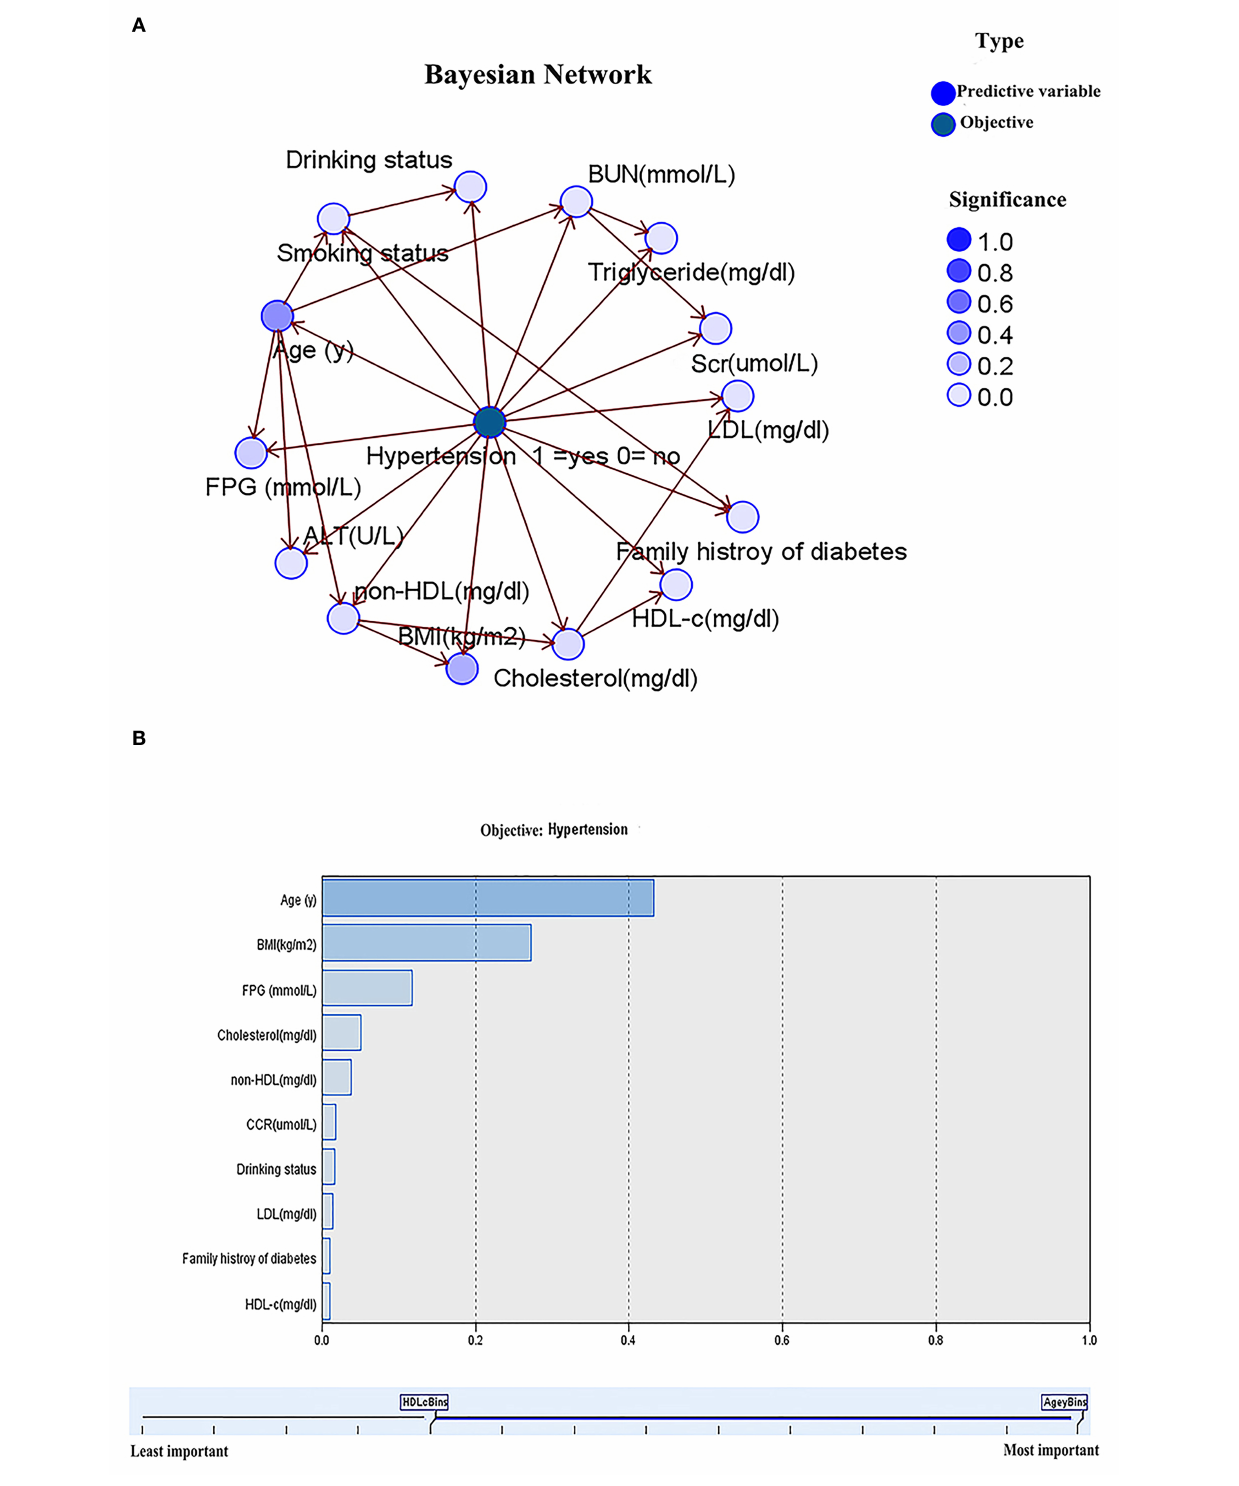
FIGURE 3 | Bayesian network model for hypertension based on TAN algorithm (A) ; Importance of predictors (B) .